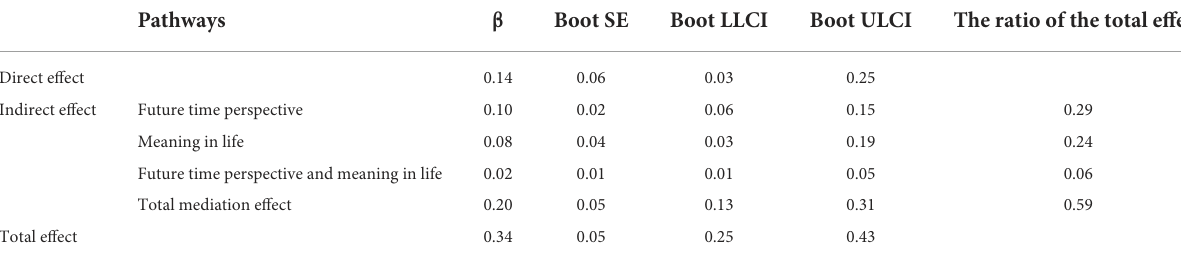
TABLE 3 The mediating effects of future time perspective and meaning in